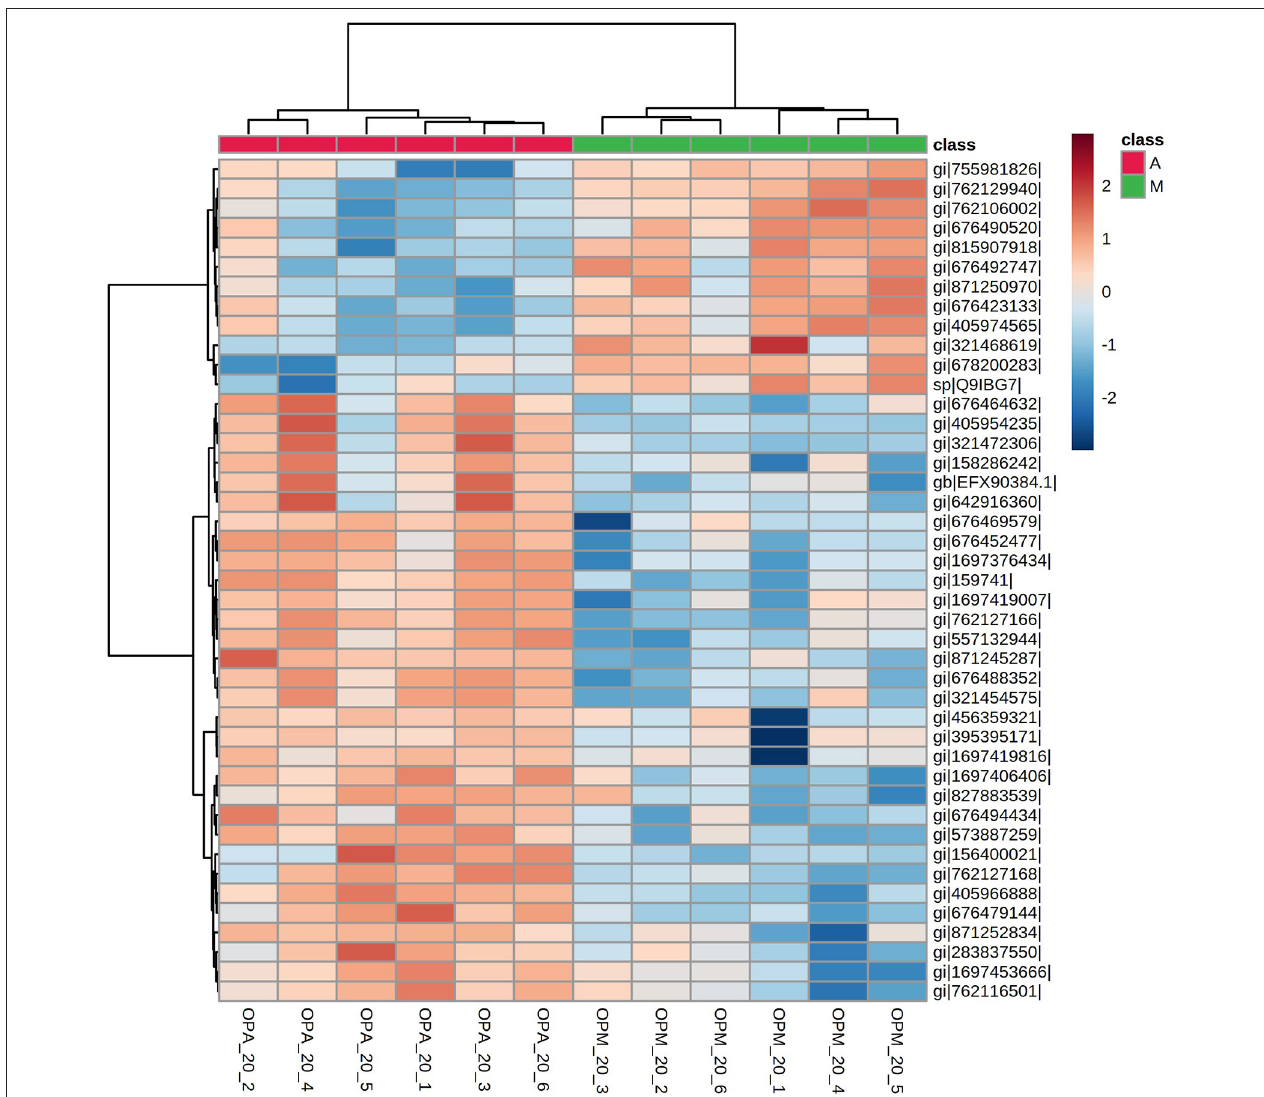
FIGURE 7 | A heatmap showing hierarchical clustering of proteins with significant changes in abundance related to diet found in the SWATH-MS proteomics analysis in O. vulgaris paralarvae of 20 days post-hatching fed on improved mixed diet (M) and Artemia -based diet (A). This subset of 43 proteins showing changes in abundance (fold-change > 2 and p -value < 0.01) allowed the complete separation of both experimental groups. See Supplementary Table 4 for complete